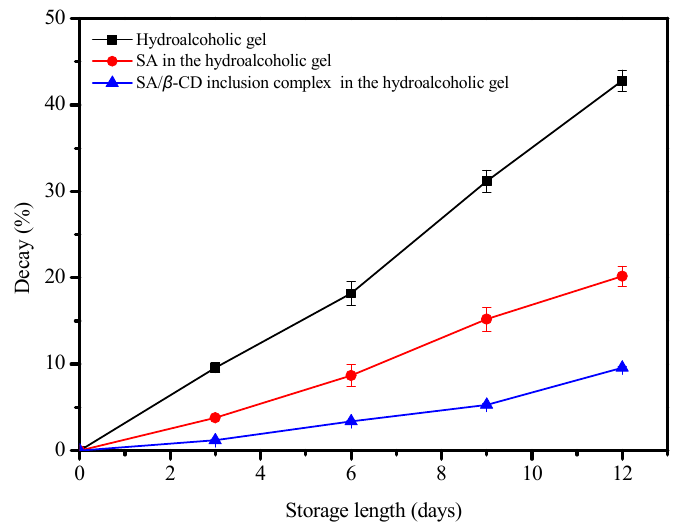
Figure 2. Effects of control, SA, and SA/ β -CD treatments on decay rates of fresh-cut bananas during 12 days of storage at 85% RH at 20 °C.